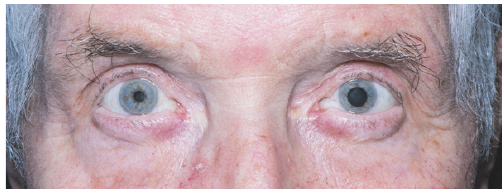
Figure 1: Dilated left pupil seen in comparison to contralateral side. This abnormality had been present since an ocular injury during a football game more than 45 years earlier. Informed consent was obtained for the use of this